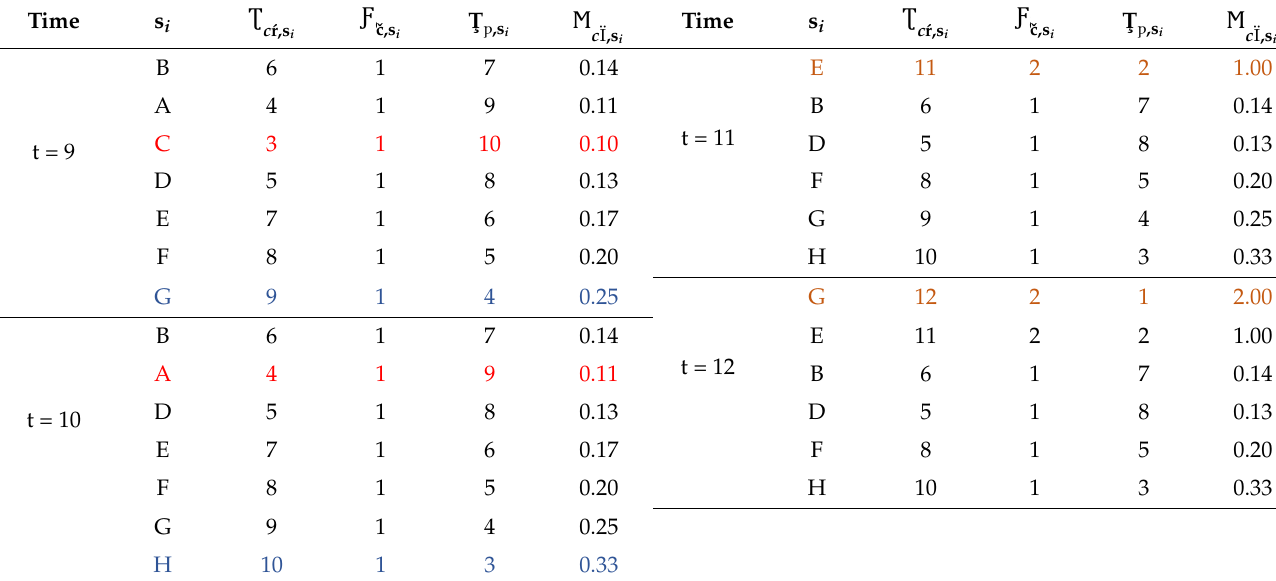
Algorithm 1: Determine the mature and immature content.